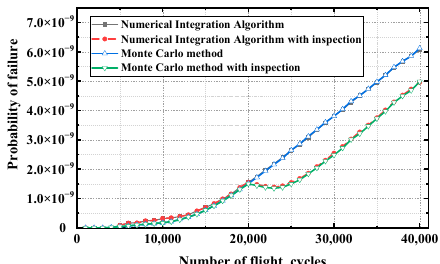
Figure 12. Comparison of the time costs of different methods.